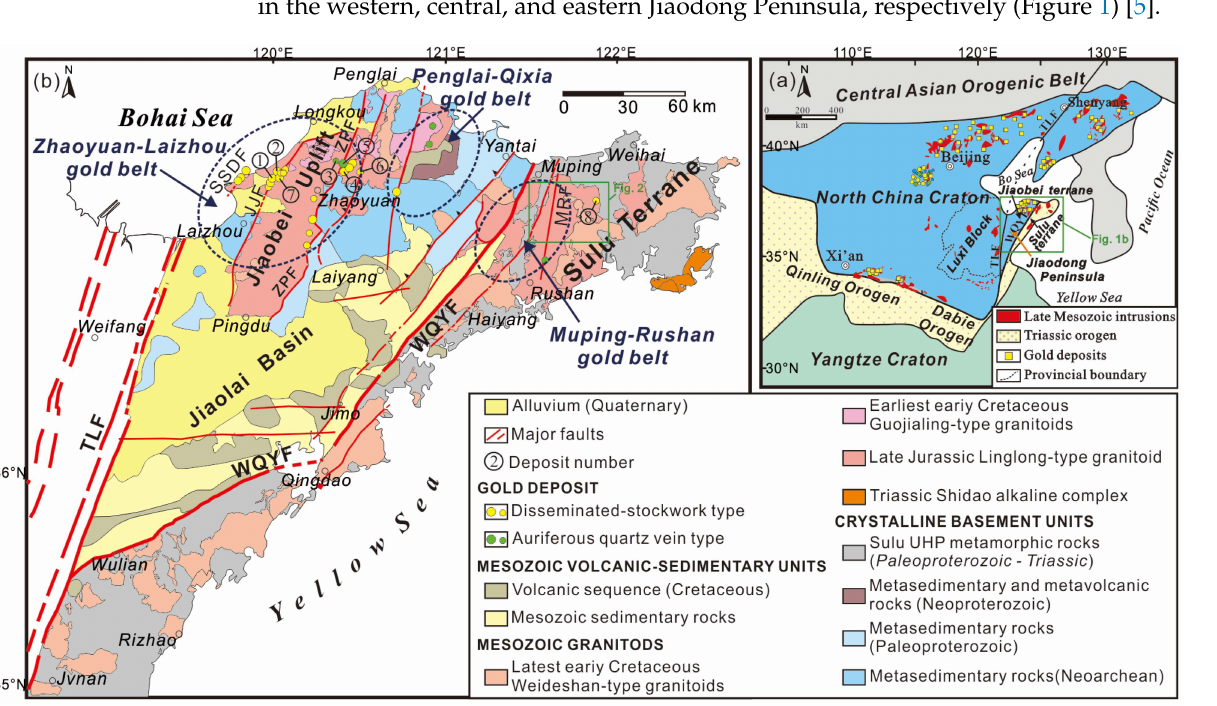
Figure 1. ( a ) A simplified tectonic map of the North China craton showing the location of the Jiaodong Peninsula. Adapted with permission from Ref. [6]. 2012, Elsevier. ( b ) A simplified geological map of the Jiaodong Peninsula showing the distribution of crystalline basement, Mesozoic volcanic- sedimentary sequence and granitoids, major structures, and typical gold deposits. Adapted with permission from Ref. [1]. 2015, Elsevier. Main faults: WQYF, Wulian–Qingdao–Yantai Fault;